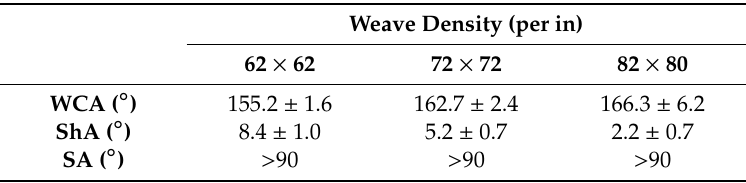
Table 3. Water contact, shedding, and sliding angles of the polypropylene (PP) fabric that underwent plasma etching for 15 min and thermal aging for 1 h (E15H120 1 h).